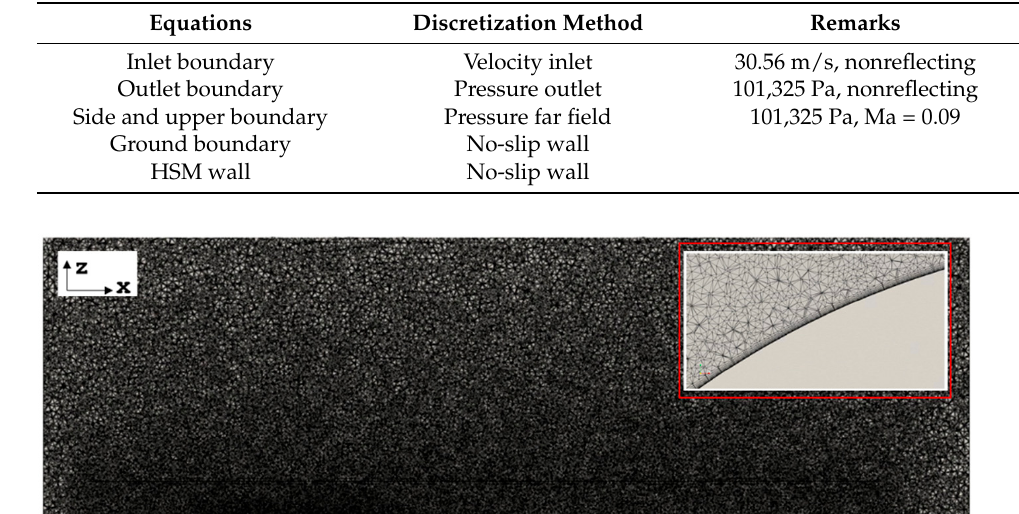
Figure 4. Grid description of computational domain in x – z plane.